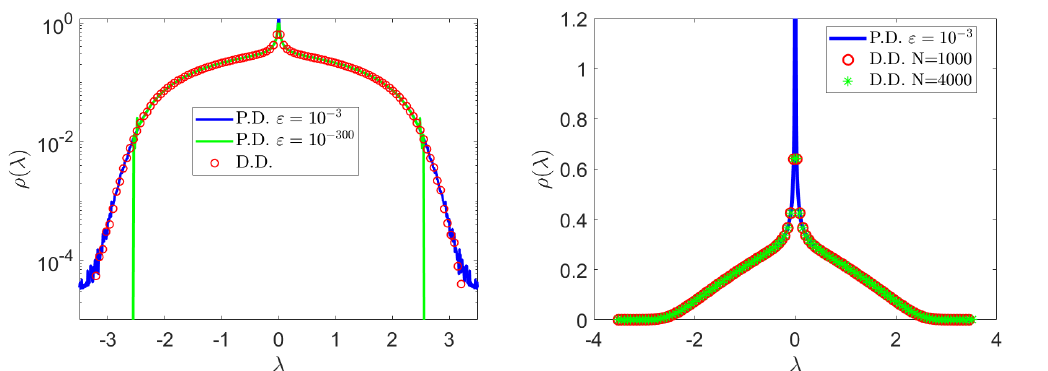
Figure 4: Spectral density of ER matrices with mean degree c = 4 and Gaussian bond weights with zero mean and variance 1 / c . Left : population dynamics results obtained with a regulariser (cid:34) = 10 − 3 (solid blue line) and (cid:34) = 10 − 300 (solid green line) vs. direct diagonalisation results (red circles) obtained from a sample of 10000 matrices of size N = 1000. The plot is on a logarithmic scale. Right : comparison between population dynamics result with (cid:34) = 10 − 3 (solid blue line), direct diago- nalisation results obtained from a sample of 10000 matrices of size N = 1000 (red circles) and direct diagonalisation results obtained from a sample of 2500 matrices of size N = 4000 (green